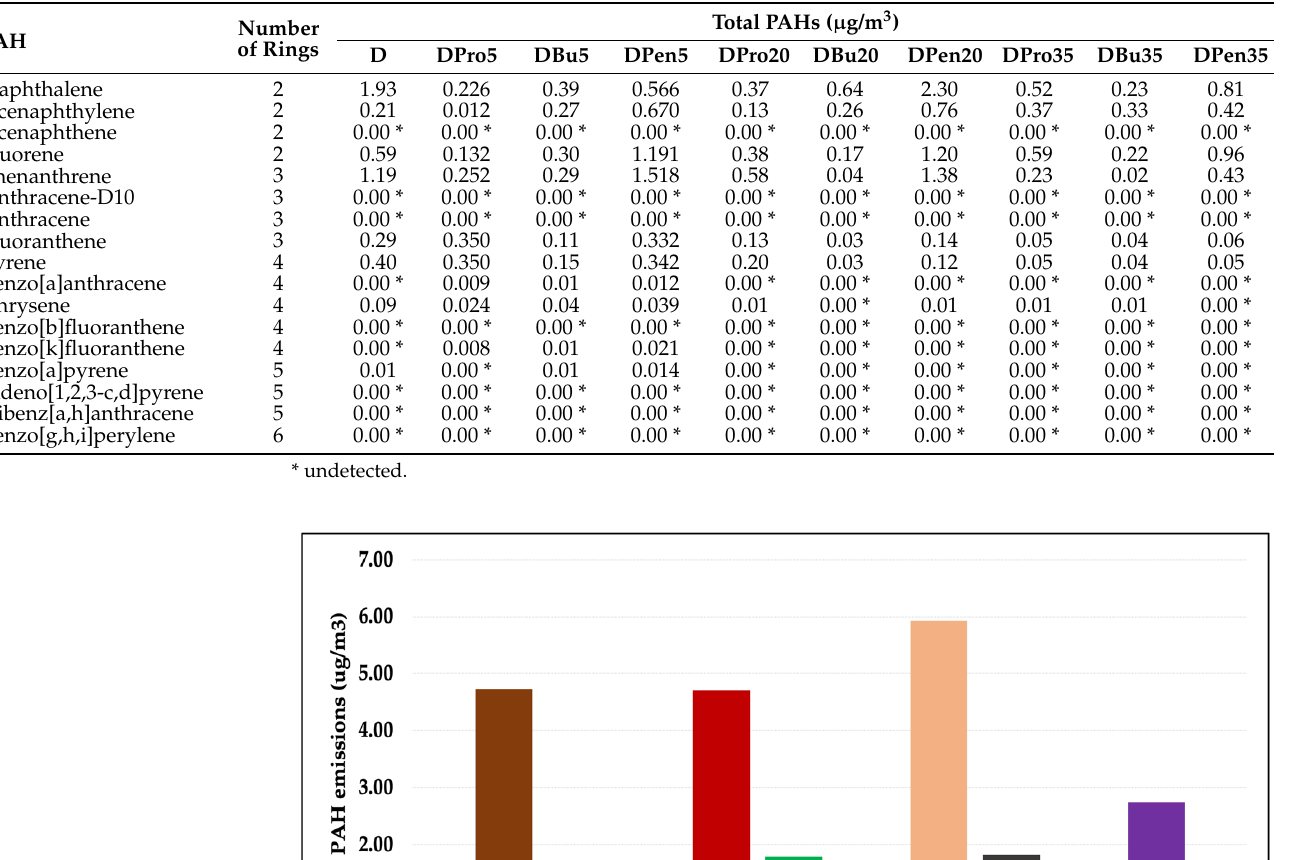
Table 5. PAH concentration in exhaust gas.